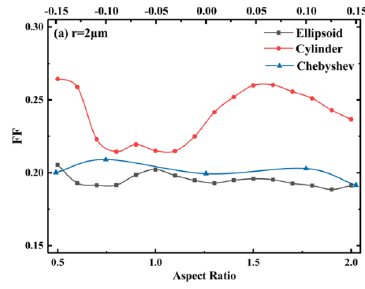
Figure 3. The integral forward scattering and back-scattering phase function relationship with aspect ratio( r =2μm) of sulfate particle. (a) forward scattering phase function; (b)backscattering phase function Figure 4. Depolarization of three different shapes of particles at different scattering angles.